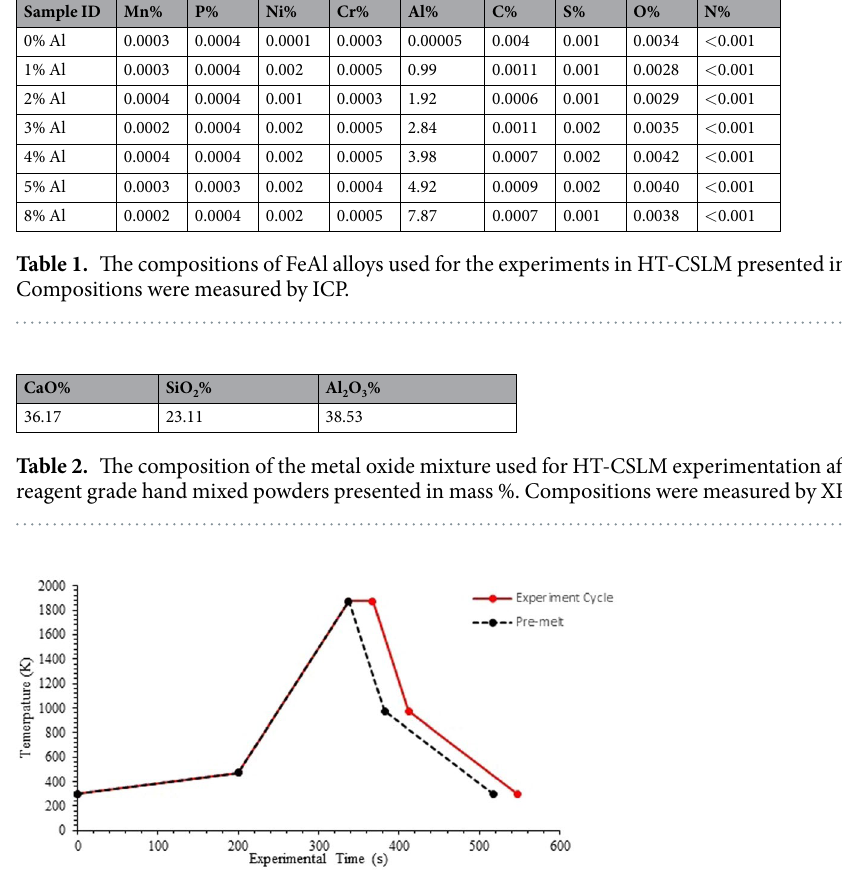
Figure 2. The nominal heating cycle used for both pre-melting of metal oxides and experimentation of oxide/ metal alloy reaction in the